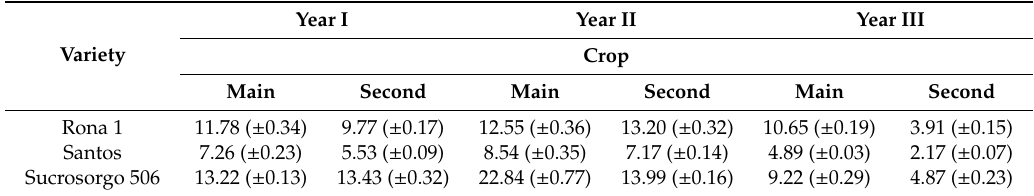
Table 5. Descriptive statistics (mean, standard error) for bioethanol yield per hectare from sorghum straw (m 3 · ha − 1 ).